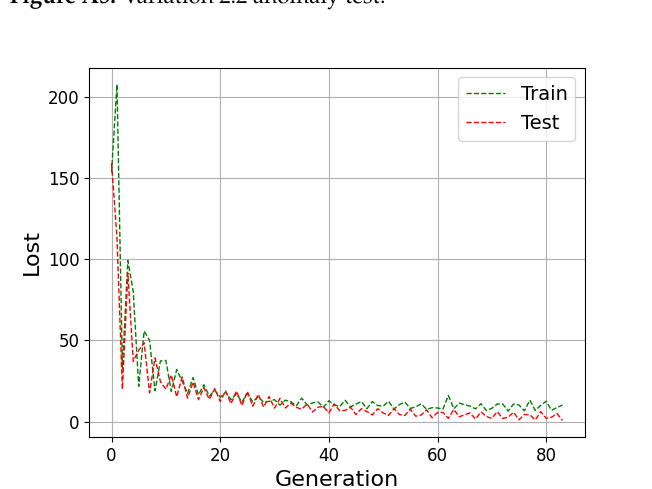
Figure A5. Variation 2.2 anomaly test.